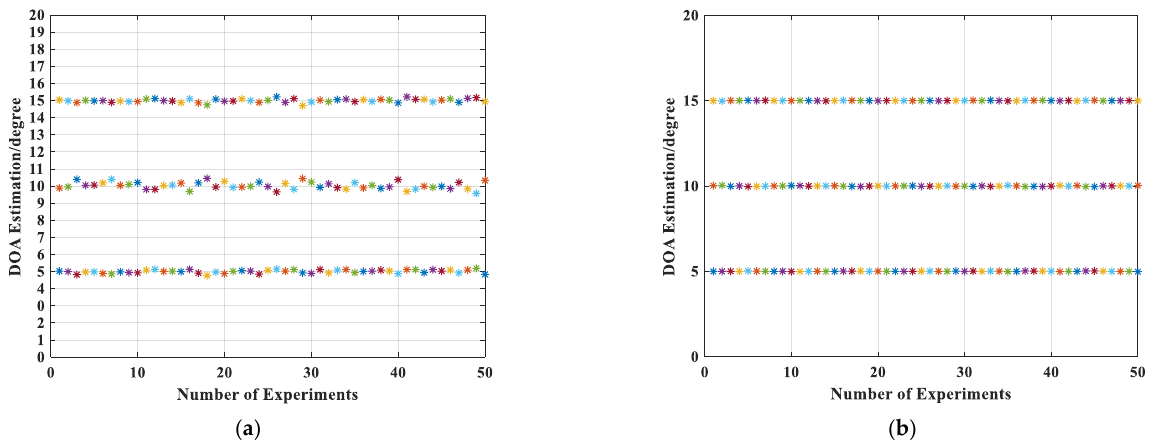
Figure 3. Coherent DOA estimation results over 50 trails in Case 1. ( a ) SNR = 0 dB; ( b ) SNR = 20 dB.